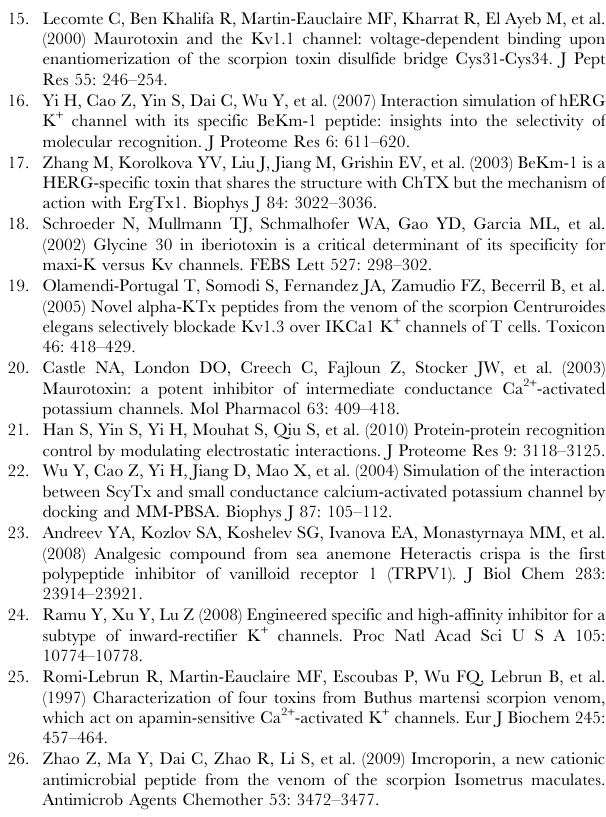
channel; (C) and (D) Inhibition of Kv1.1 and Kv1.2 channel currents with 1 m M ImKTx104. Representative results are shown (n . 3). Figure S3 NMR spectra of ImKTx104 at pH 5, 27 u C. (A) 15 N, 1 H-HSQC. (B) Expanded H a /HN and H b /HN region of NOESY spectrum at a mixing time of 120 ms.